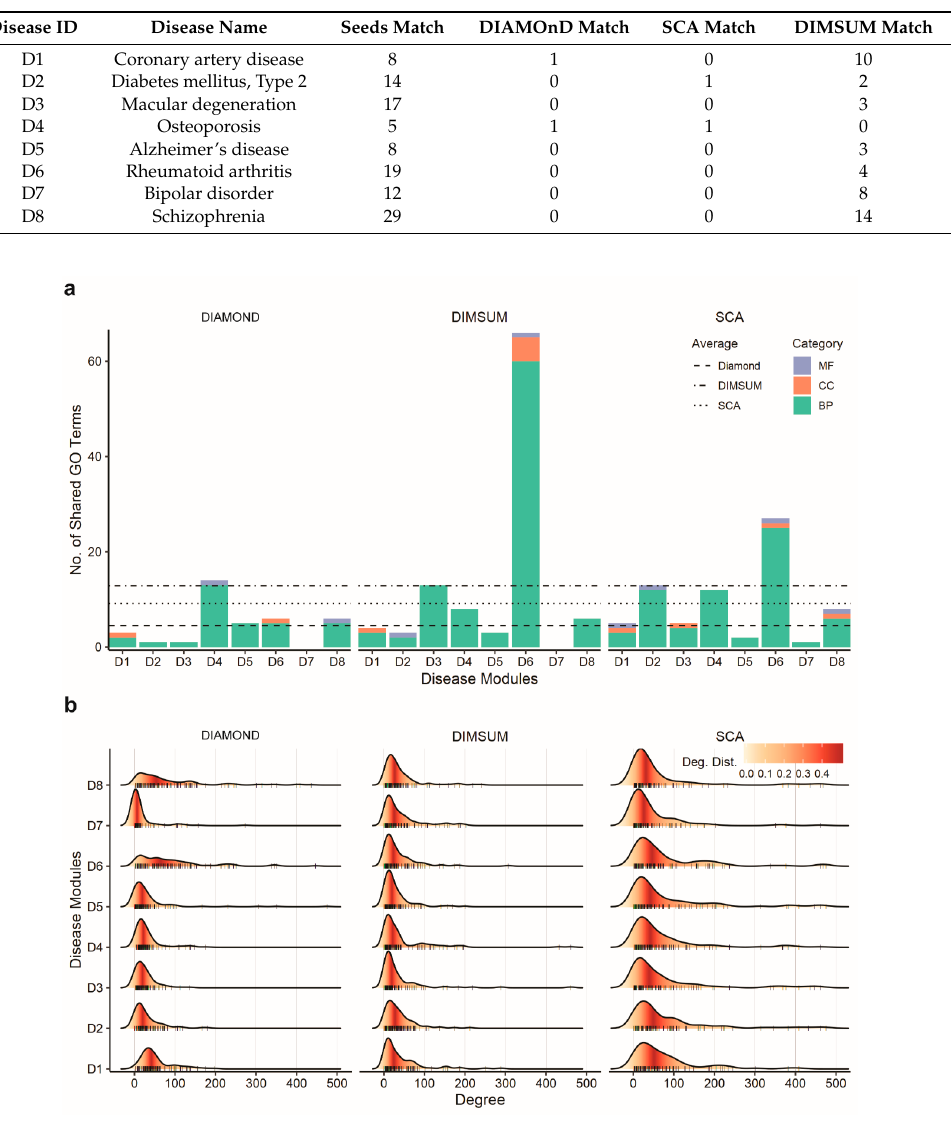
Figure 3. Comparison of biological relevance and topological properties of disease modules detected using three methods. ( a ) Bar graphs representing the number of the GO terms enriched in the added genes overlapped with the seed genes for DIAMOnD, SCA, and DIMSUM for the eight disease modules. The three GO term categories are Cellular Component (CC), Molecular Function (MF), and Biological Process (BP). The average of significant and identical GO terms from DIMSUM is higher than from DIAMOnD or SCA. ( b ) Degree distribution of the added genes during module detection for the eight diseases by each method. When building a module, DIMSUM avoids bias towards always including the nodes of high degree and has lower node degrees for all eight modules.